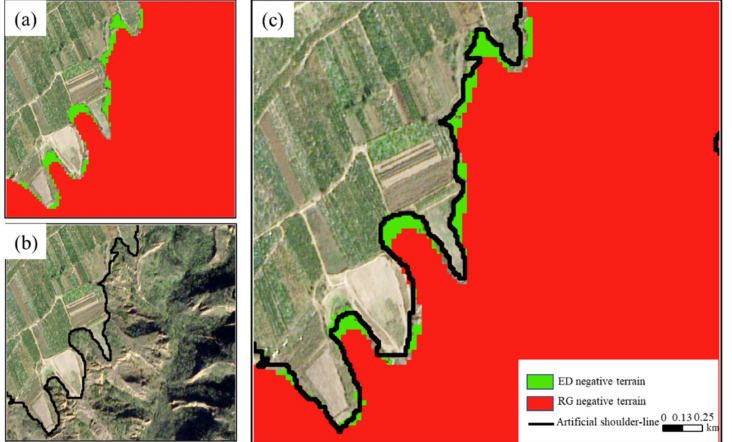
Figure 12. Comparison of shoulder lines between edge detection, regional growing algorithm, and manual visual interpretation. ( a ) represents the results of edge detection method and regional growing algorithm; ( b ) represents the results of manual visual interpretation; ( c ) represents the overlay of extraction results from different